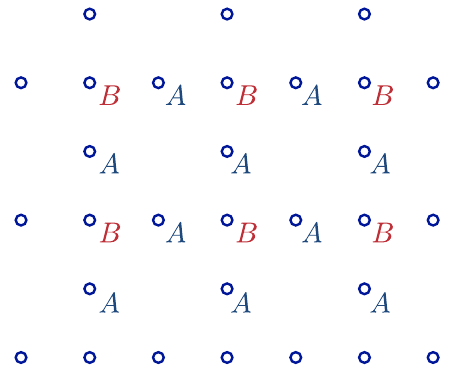
Figure 3.1: The Lieb lattice. Each A site has only B neighbours and vice versa, but there are twice as many A sites as there are B